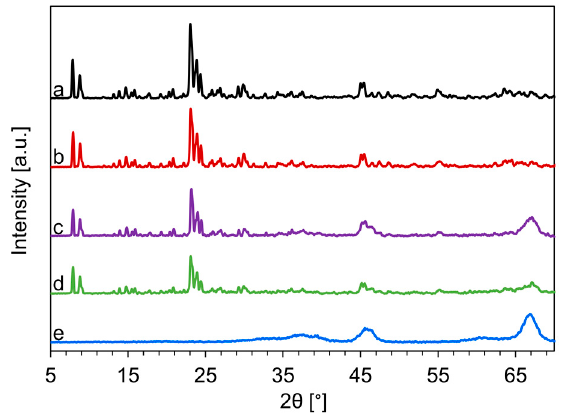
Figure 1. XRD-pattern of commercially available (c)-HZSM-5 (a), nano (n)-HZSM-5 (b), physical mixture of nano-HZSM-5 and γ -Al 2 O 3 (PM-50 / 50) (c), the hybrid catalyst (Hybrid-50 / 50) (d), and γ -Al 2 O 3 (e).